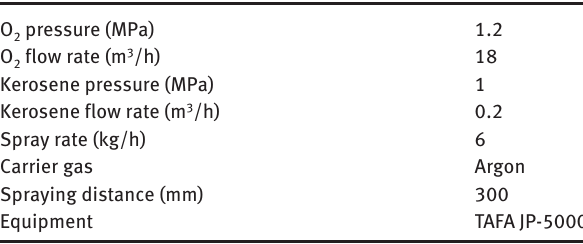
Table 1: Spray parameters of WC-12Co coating by HVOF